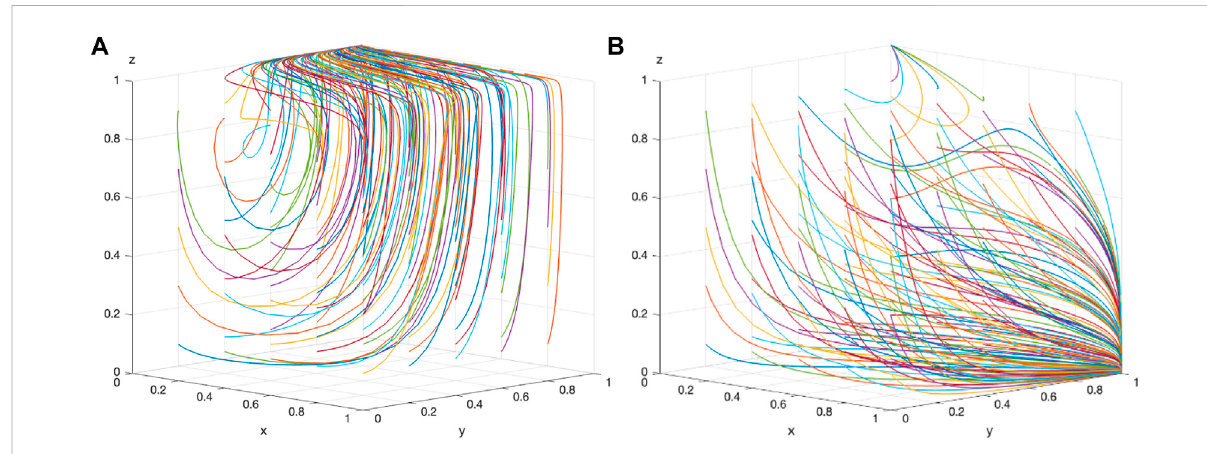
FIGURE 5 (A) The result of 50 simulations of array 1. Figure 5. (B) The result of 50 simulations of array